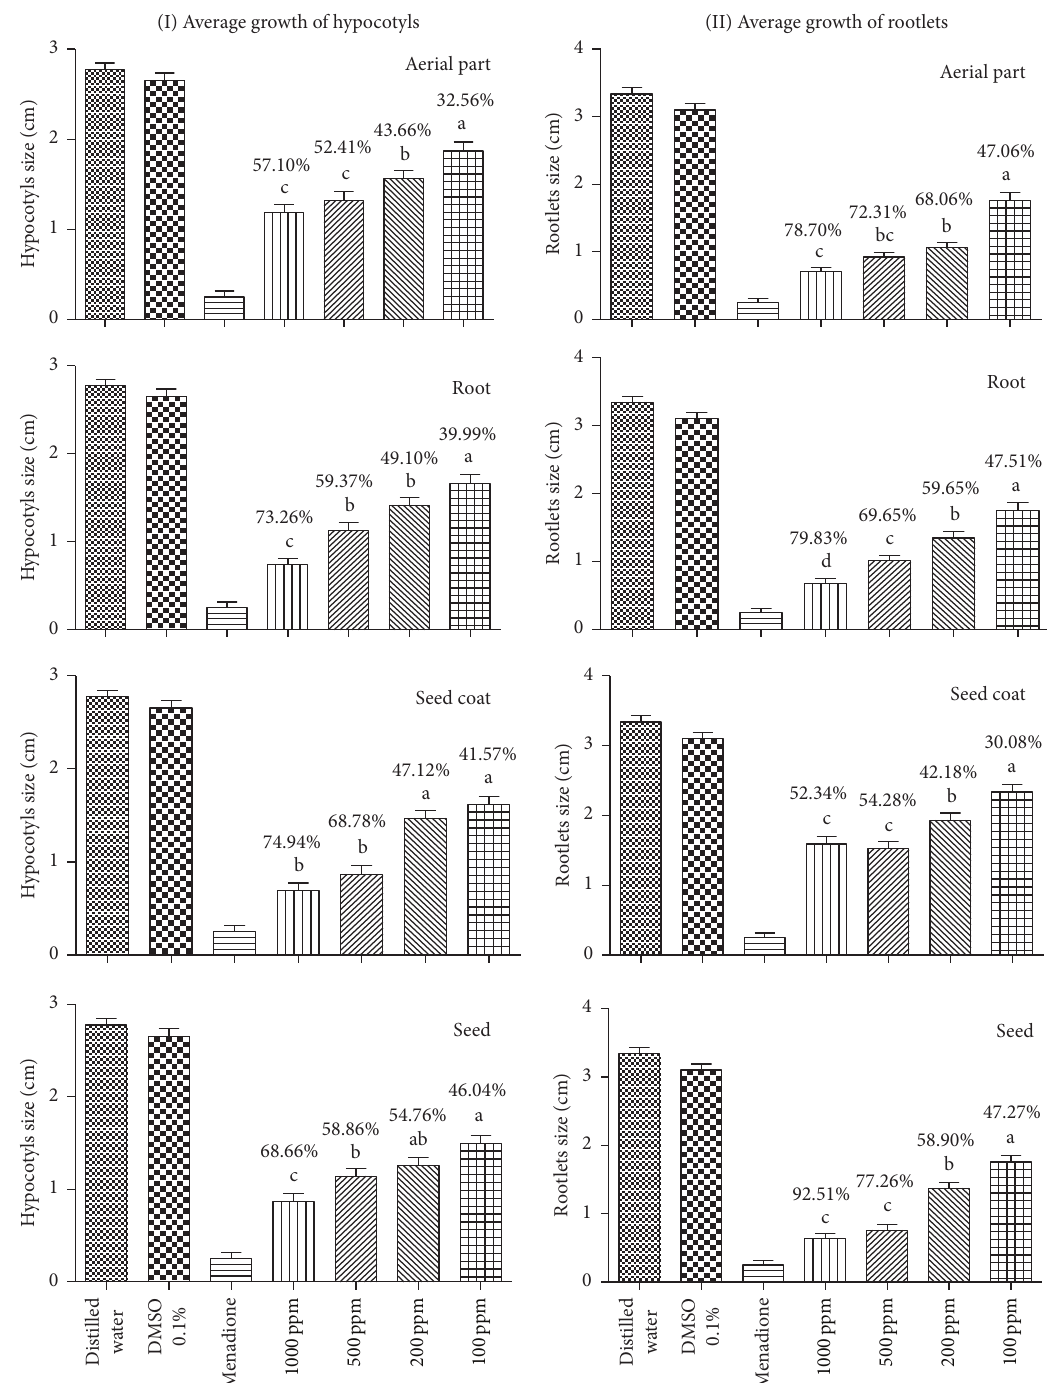
Figure 1: Evaluation of allelopathic activity of ethanolic extracts of Arachis hypogaea (cultivar BR-1) on the growth of hypocotyls and rootlets of L . sativa based on the average lengths of each organ and the inhibition percentages relative to distilled water control. The same letter means no statistically significant difference between the samples in each graphic, according to Tukey’s